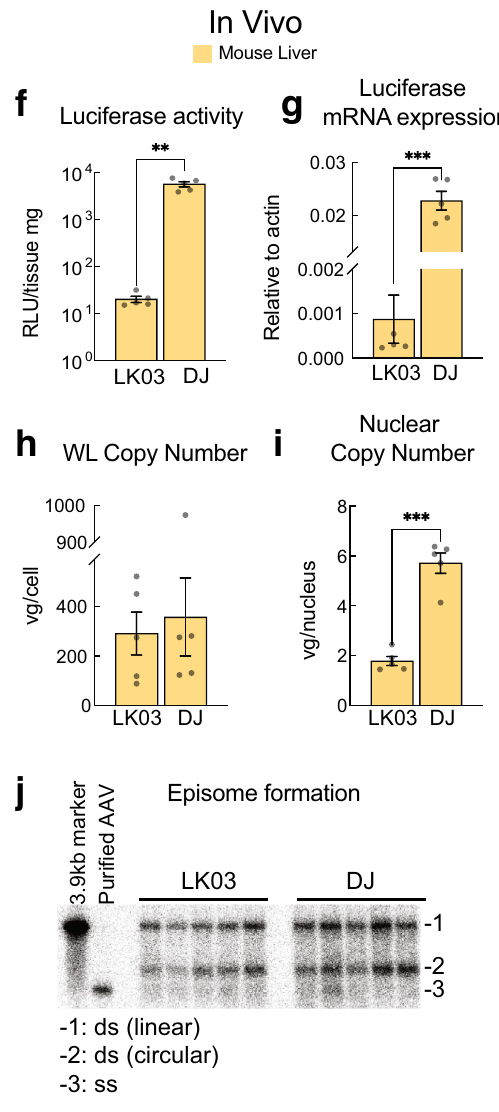
uncropped Southern blot image is provided in Source Data File 1. Statistics were performed using multiple unpaired Welch t tests ( a – e ) or unpaired t test with Welch ’ s correction ( f – i ). Only statistically signi fi cant differences are